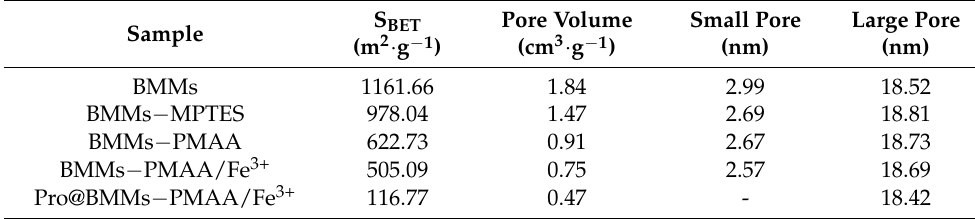
Figure 3. Size distributions ( A ), N 2 adsorption/desorption isotherms ( B ), XPS survey spectra ( C ), and curve fittings of Fe 2p peak ( D ) of Pro@BMMs − PMAA/Fe 3+ Nps and control samples. Table 1. BET and BJH measurements of the